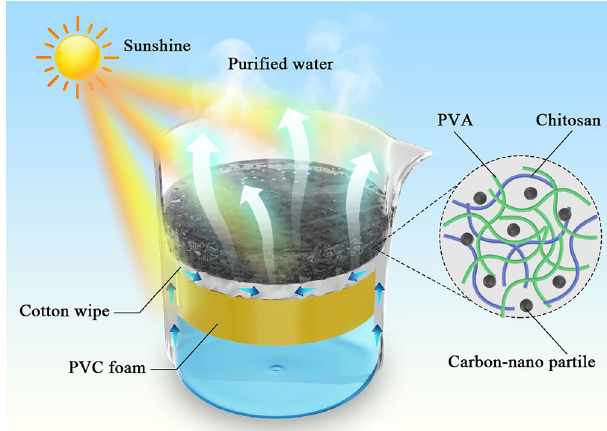
Figure 1. Schematic illustration of regular double-layer evaporation